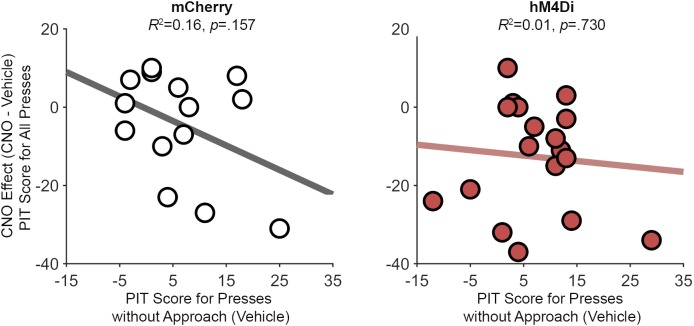
Scatter plots show the relationship between individual differences in the effect of the CS+ on lever presses that were not followed by food-cup approach in the vehicle condition (PIT score for presses without approach) and the suppressive effect of CNO on CS+ evoked lever pressing (PIT Score for CNO test - PIT Score for vehicle test).Data points are from individual rats expressing mCherry (left panel) or hM4Di (right panel).